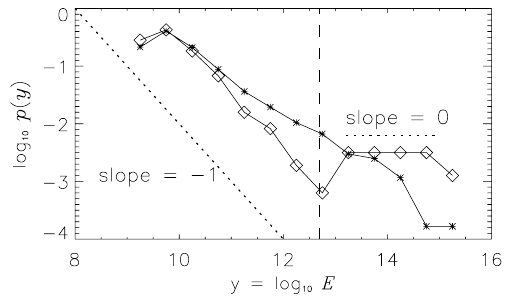
Fig. 4. Distributions of low-latitude (diamonds) and high- latitude (stars) emission events over the quantity y ≡ log 10 E . The pronounced break in the low-latitude distribution occurring at E ∗ = 5 × 10 12 J (shown with dashed vertical line) confirms the ex- istence of two distinct subpopulations ( A 1 and A 2 ) in this auroral region. The slopes to the left and to the right of this break are con- sistent with the shape of the energy distribution p(E) as discussed in the text.